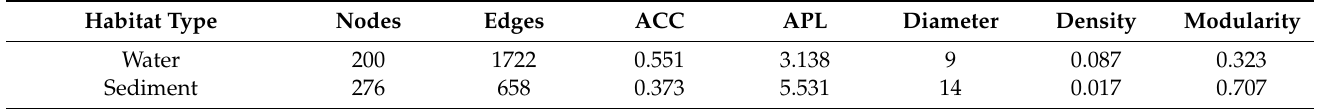
Table 2. Key topological properties of microbial